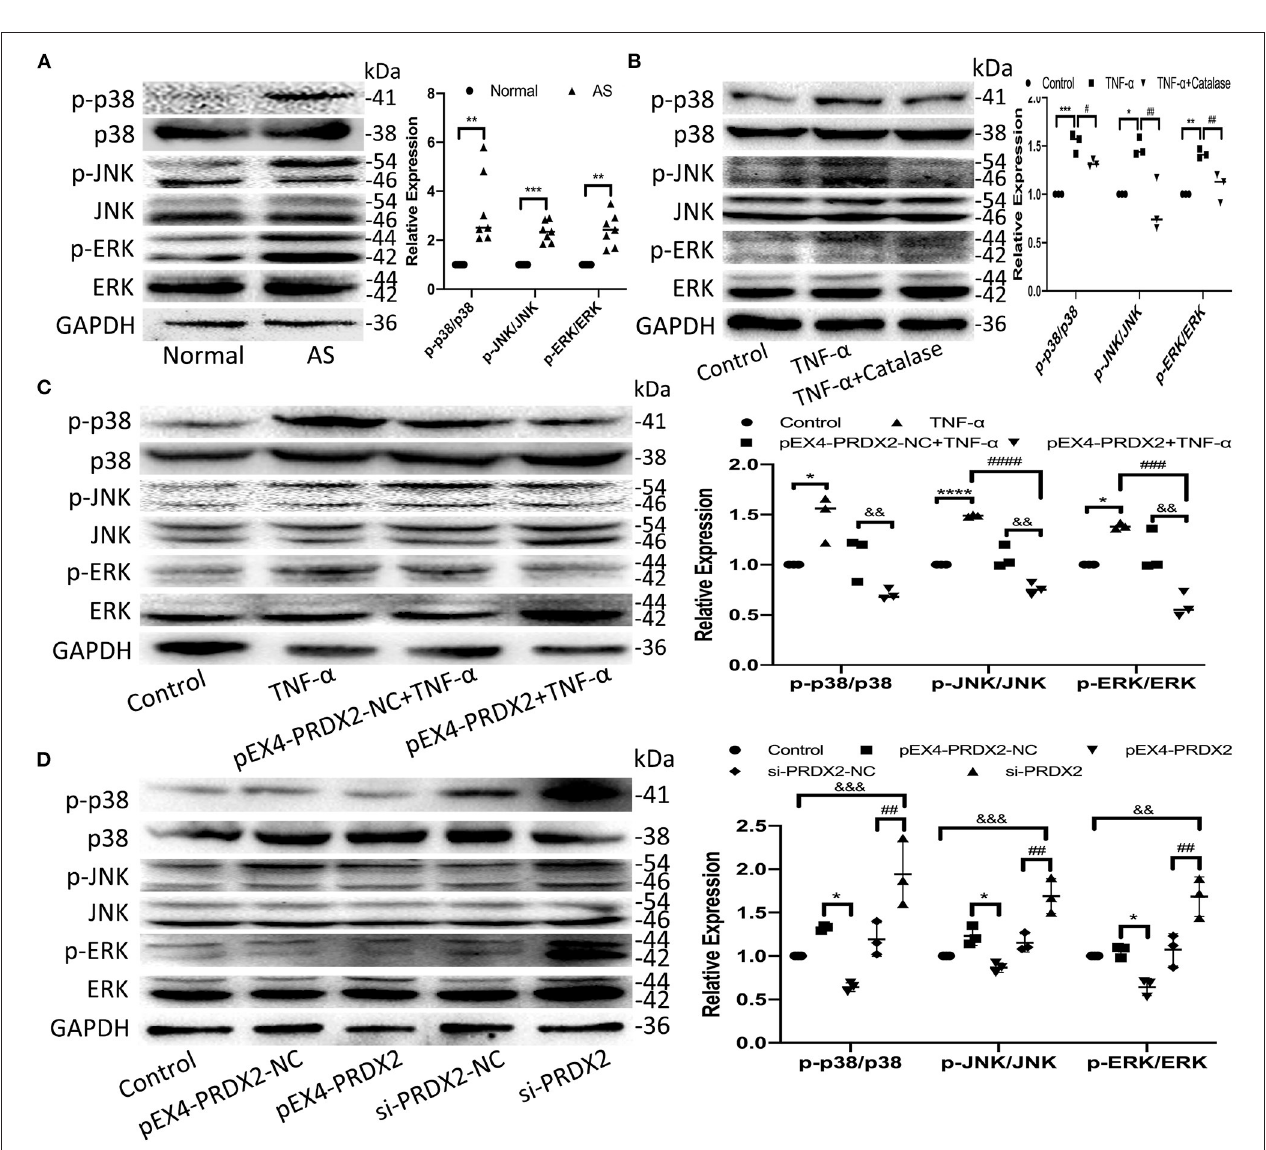
FIGURE 5 | PRDX2 inhibits the development of AS via the MAPK signaling pathway. (A) The expression of p-p38, p-ERK, and p-JNK was determined by Western blot in human carotid artery specimens ( n = 7 humans per group, ** p < 0.01 and *** p < 0.001 vs. normal group). (B) The expression of p-p38, p-JNK, and p-ERK was determined by Western blot in the CAVSMCs treated TNF- α and catalase (* p < 0.05, ** p < 0.01, and *** p < 0.001 vs. control group, # p < 0.05 and ## p < 0.01 vs. TNF- α group). (C) Western blot analyses for p-p38, p-ERK, and p-JNK in pEX4-PRDX2-CAVSMCs treated with TNF- α (* p < 0.05 and **** p < 0.0001 vs. control group, ### p < 0.001 and #### p < 0.0001 vs. TNF- α group, && p < 0.01 vs. pEX4-PRDX2-NC + TNF- α group). (D) Western blot analyses for p-p38, p-JNK, and p-ERK expression in the CAVSMCs treated with pEX4-PRDX2 and si-PRDX2 transfection (* p < 0.05 vs. pEX4-PRDX2-NC group, ## p < 0.01 vs. si-PRDX2-NC group, && p < 0.01 and &&& p < 0.001 vs. control group). The data were obtained from three independent experiments.